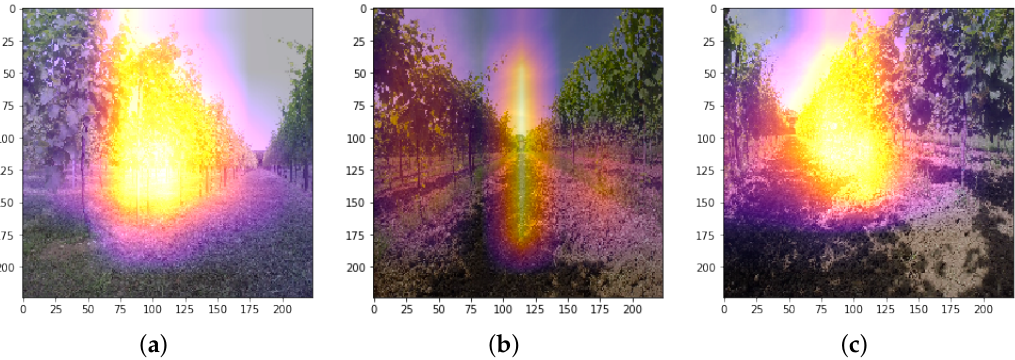
Figure 7. Gradient information, flowing into the last convolutional layer of MobileNet, is used to understand each neuron for a decision of interest. It is possible to assess that for either the three classes, ( a – c ), the network is “looking” at the vineyard roads and their vanishing point.